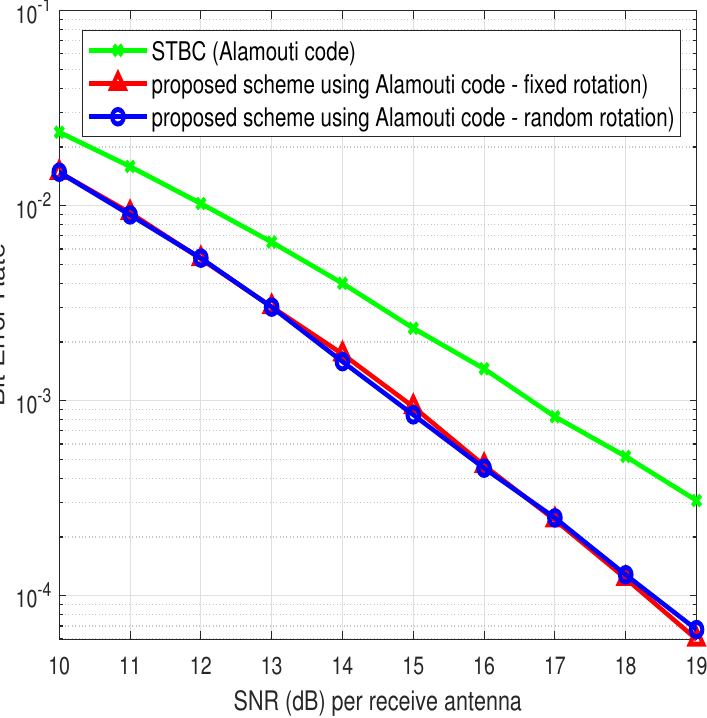
Figure 5. Performance of the proposed scheme based on QPSK − modulated STBC, M T = 2, M R = 1, L = M =